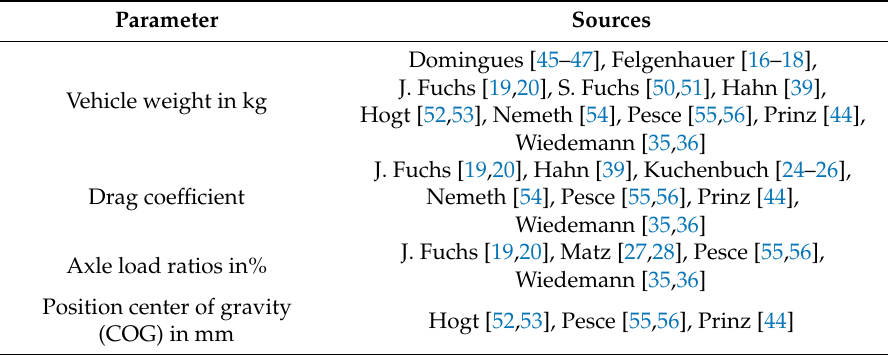
Table 9. Overview of the design parameters for the vehicle characteristics.